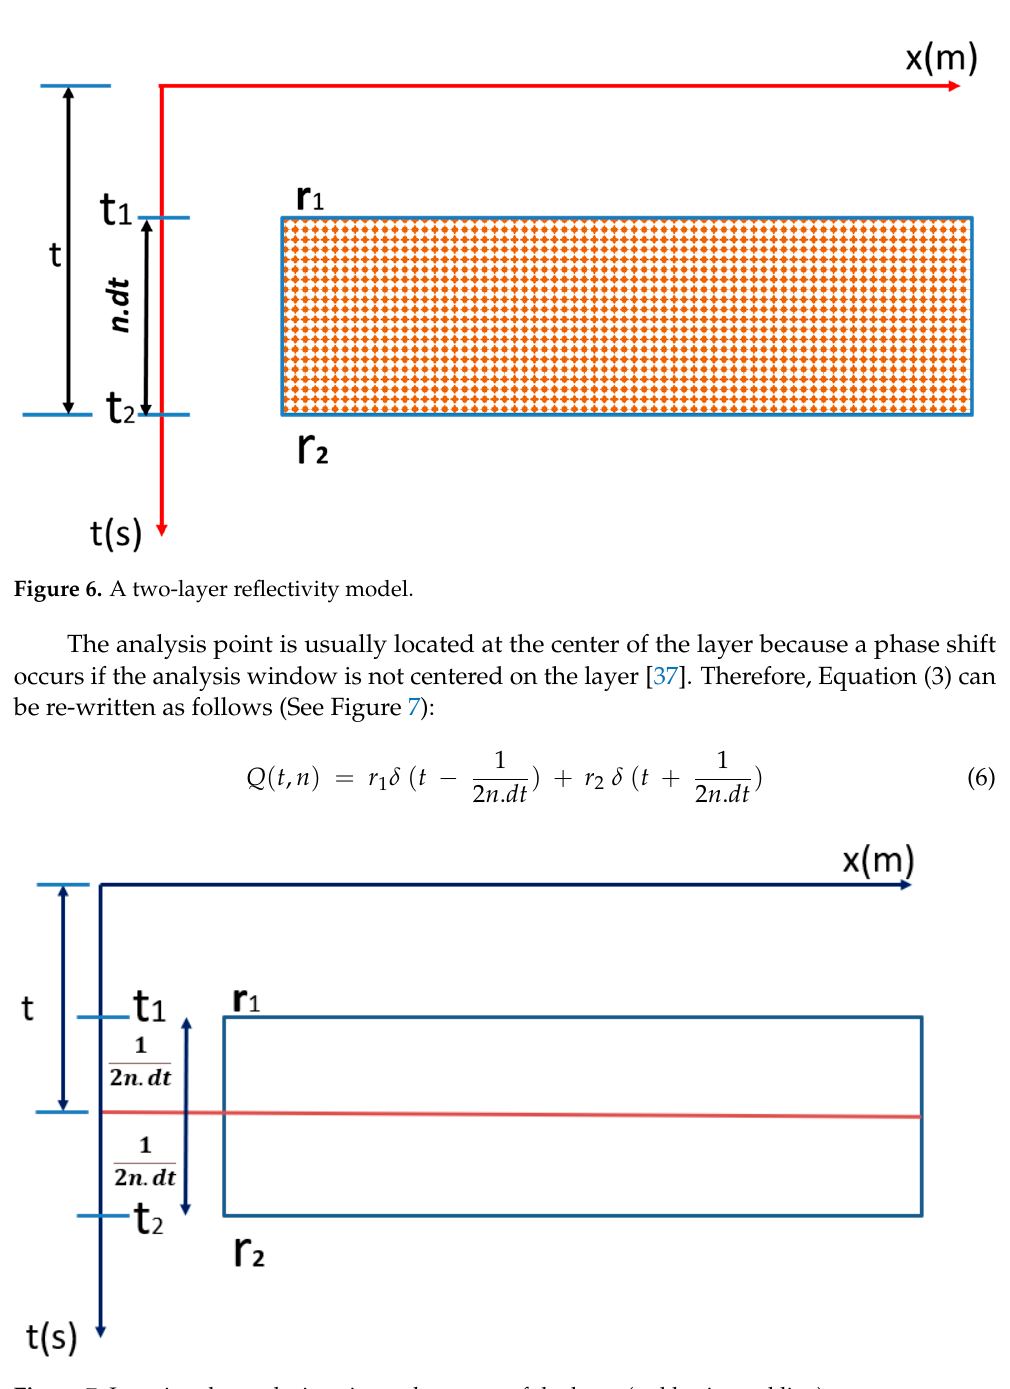
Figure 7. Locating the analysis point at the center of the layer (red horizontal line).